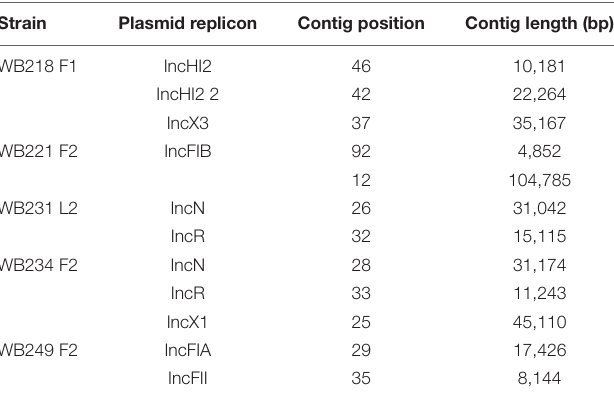
For each strain, the incompatibility group (plasmid replicon) is highlighted with the related number of contig on which the replicon was found and the length of the